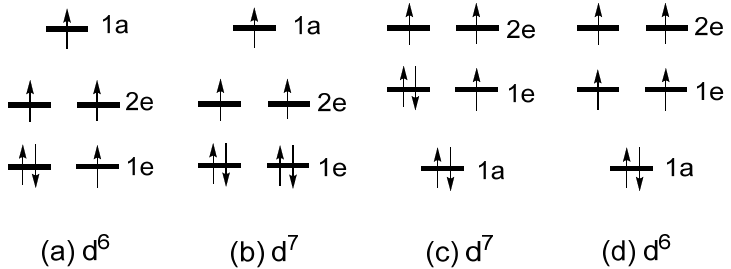
Figure 6. ( a , b ) The high-spin d 6 and d 7 configurations of ML 2 based on the d-state split patter of 1e < 2e < 1a. ( c , d ) The high-spin d 6 and d 7 configurations of ML 2 based on the d-state split pattern of 1a <